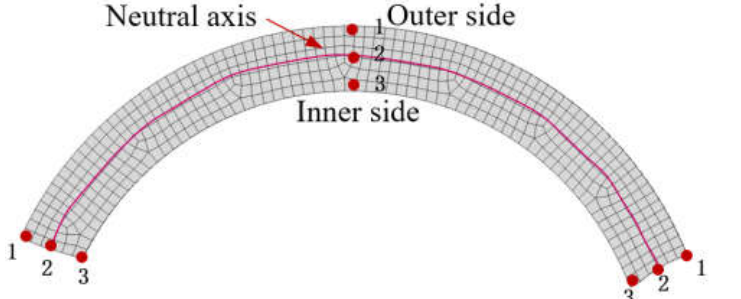
Figure 8. The measuring points of tunnel lining. Table 5. The maximum stress of typical section of tunnel lining (unit: MPa). Measuring Points